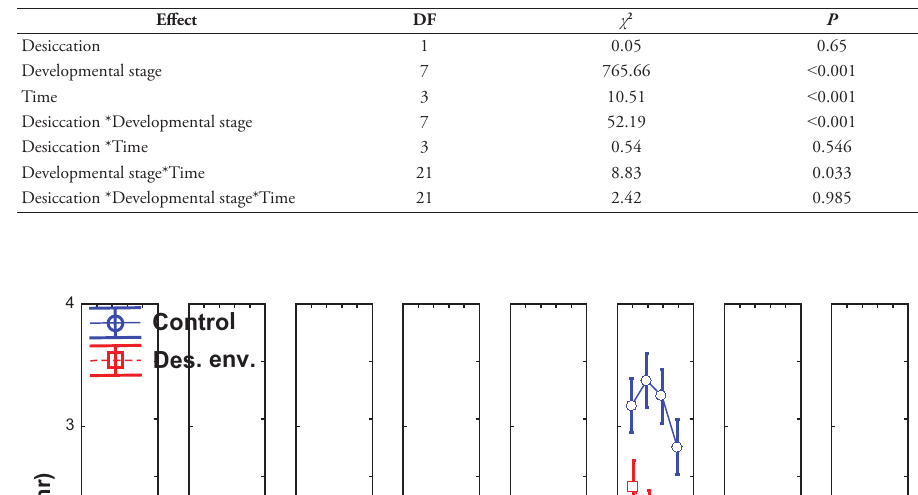
Table 2. Summary statistical results from factorial analysis using generalized linear model (GLM) on the effects of desiccation, developmental stage and interaction thereof on S. frugiperda water loss rates. All analyses were done in R version 3.3.0. DF = degrees of freedom.